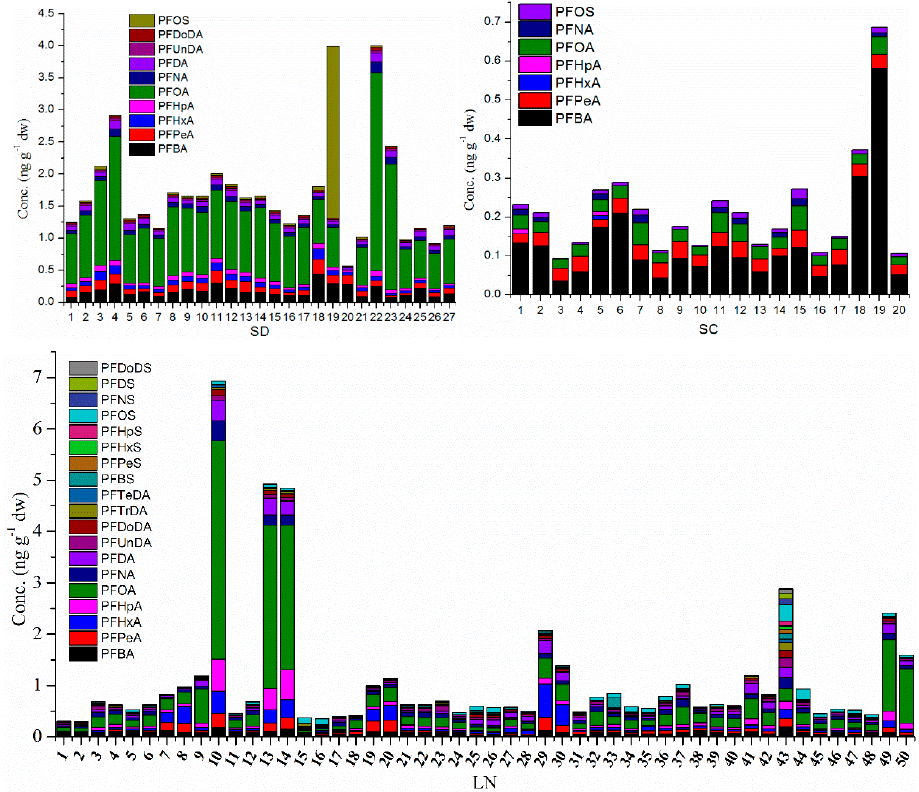
Figure 3. The level of PFAAs in soil samples from Shandong (SD), Sichuan (SC) and Liaoning (LN) provinces. The odd numbers represent the top soil and the even ones represent the deep soil for SC and LN.